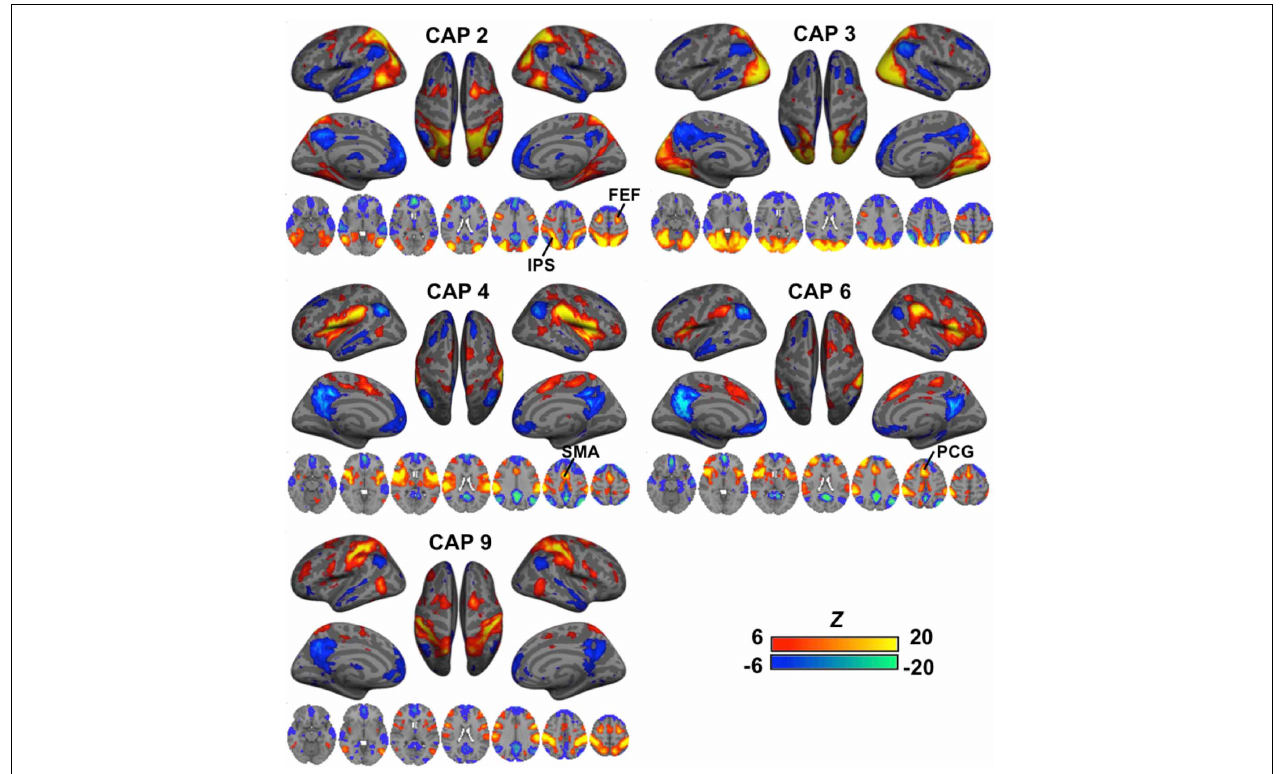
FIGURE 3 | CAPs showing distinct co-activation in “task-positive” regions (i.e., activated with common tasks) but consistent de-activation in the “task-negative” areas (i.e., de-activated with common tasks). Their patterns appeared more distinct from one another as compared to the DMN-activated CAPs. While CAPs 2 and 3 are both related to the visual system, CAP 2 overlaps more on the high order visual area and frontal eye fields (FEF). CAPs 4 and 6